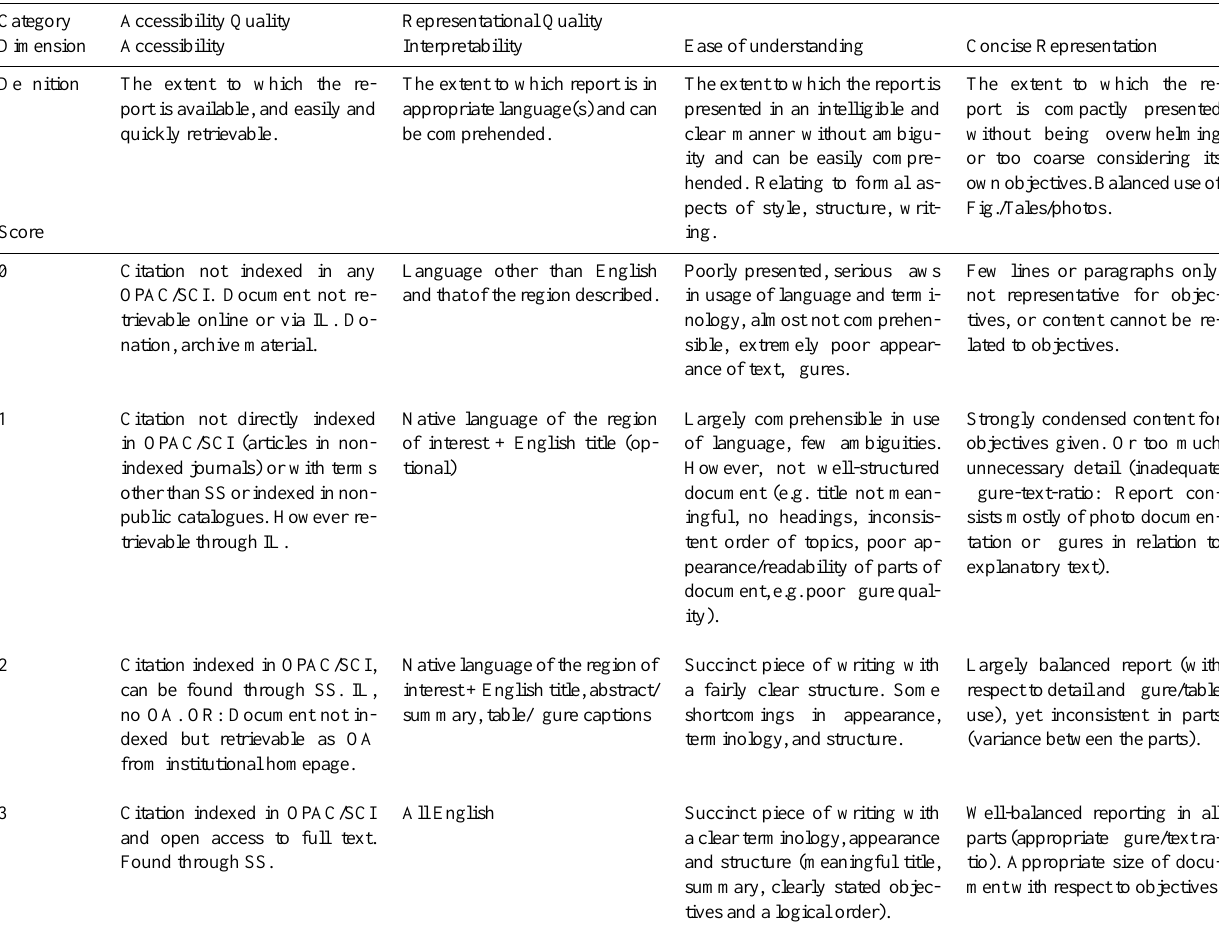
Table A1. Definitions of the quality dimensions and their respective scores for the “Accessibility” and “Representational Quality” quality